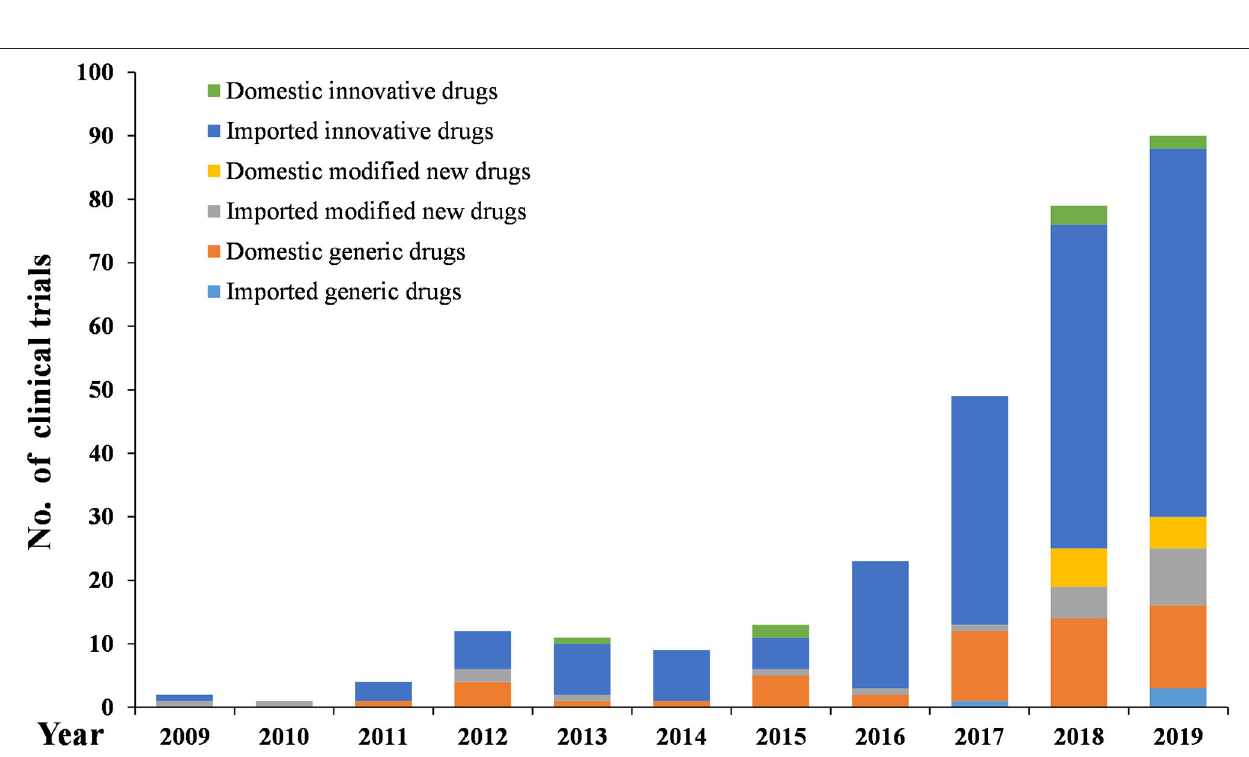
Frontiers in Medicine |